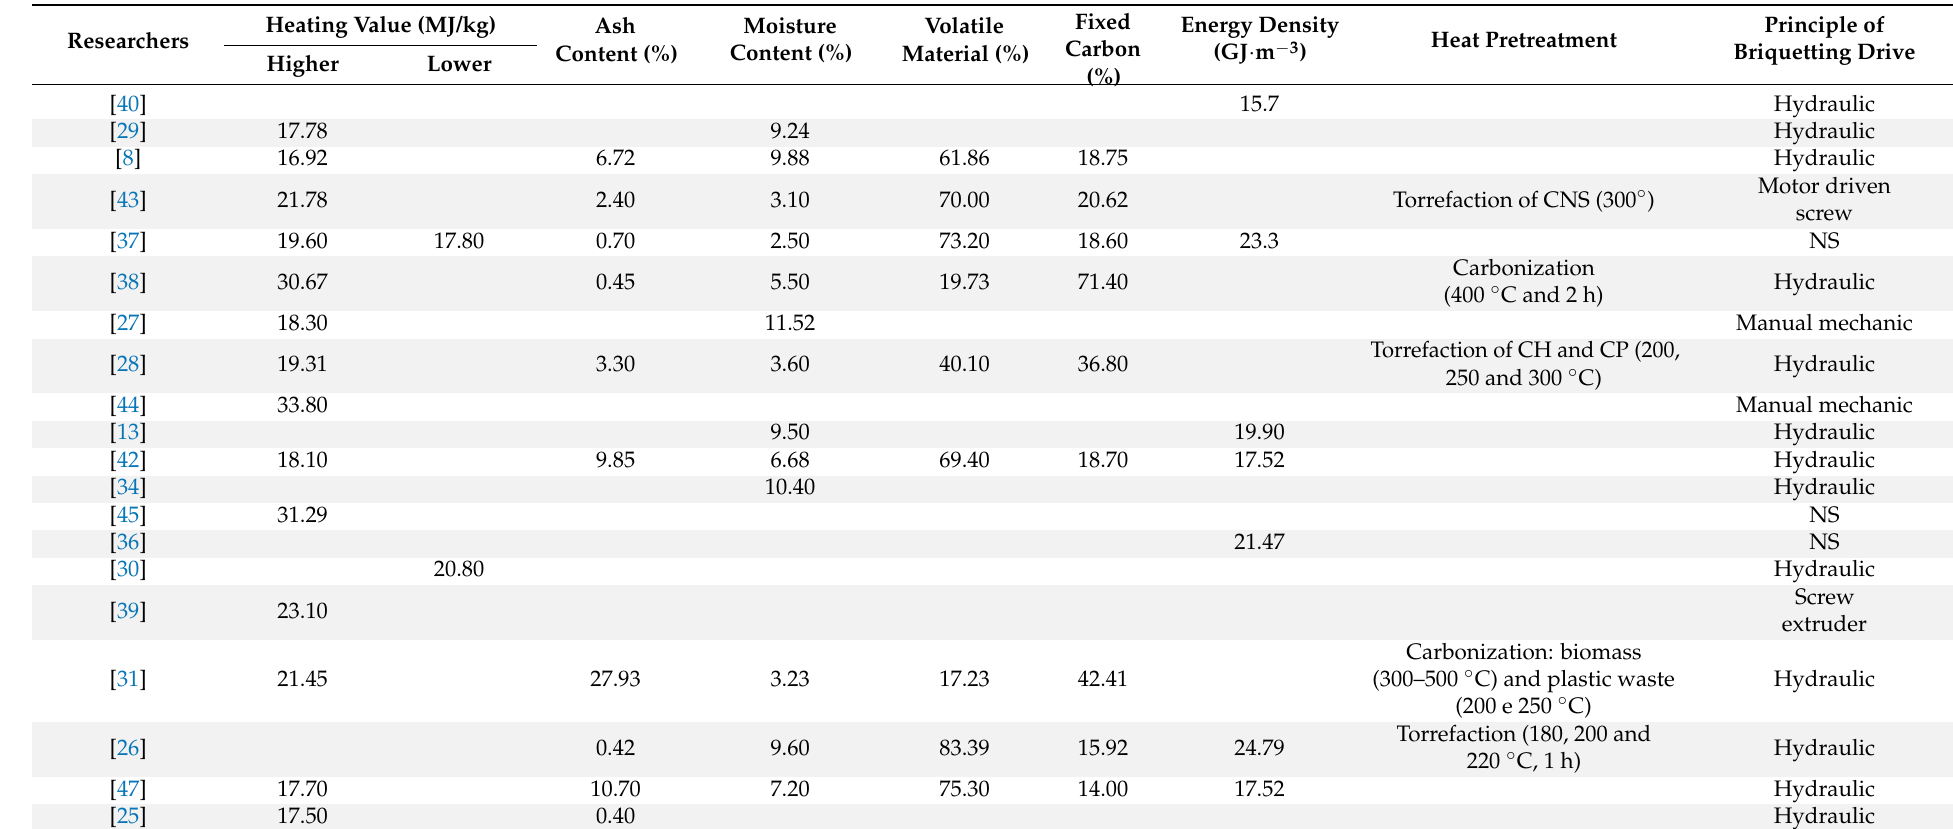
Table 10. Main energy and combustion output variables to qualify the